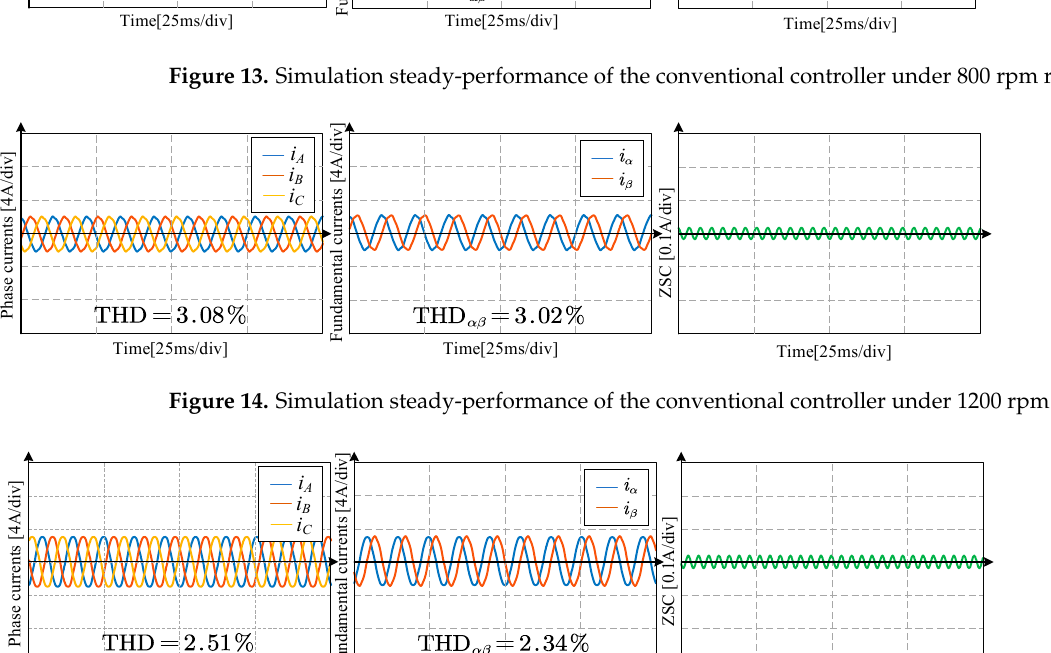
Figure 12. Simulation dynamic performance of proposed FW-DFVL. In Figure 14, the series-winding PM machines should operate in the fl ux-weakening condition. While since the utilized voltage limit V dc cannot be reached, the system cannot work correctly in the fl ux-weakening operation region. Both the fundamental currents and the phase currents are distorted. Similar performance is also observed in Figure 15.